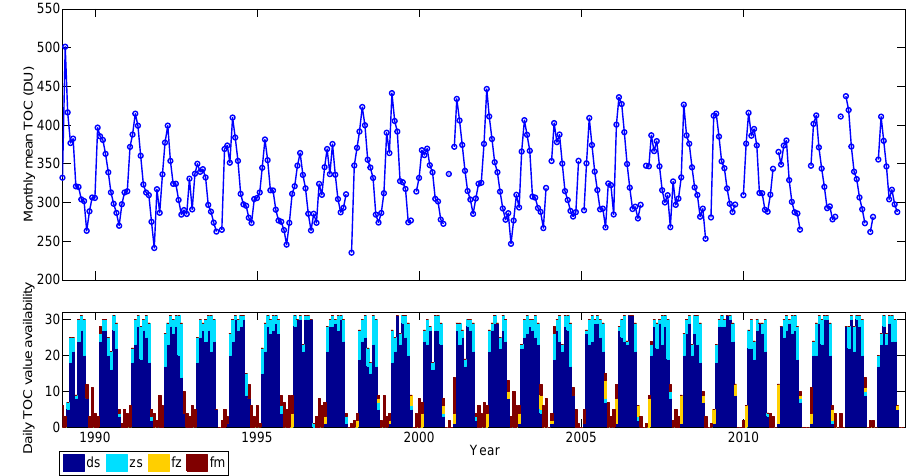
Figure 2. Upper panel shows the monthly mean ozone calculated from daily values. The amount of daily values available for each month is shown in the lower panel. Different measurement styles have been color coded to show which type of measurements have been used for monthly mean value.